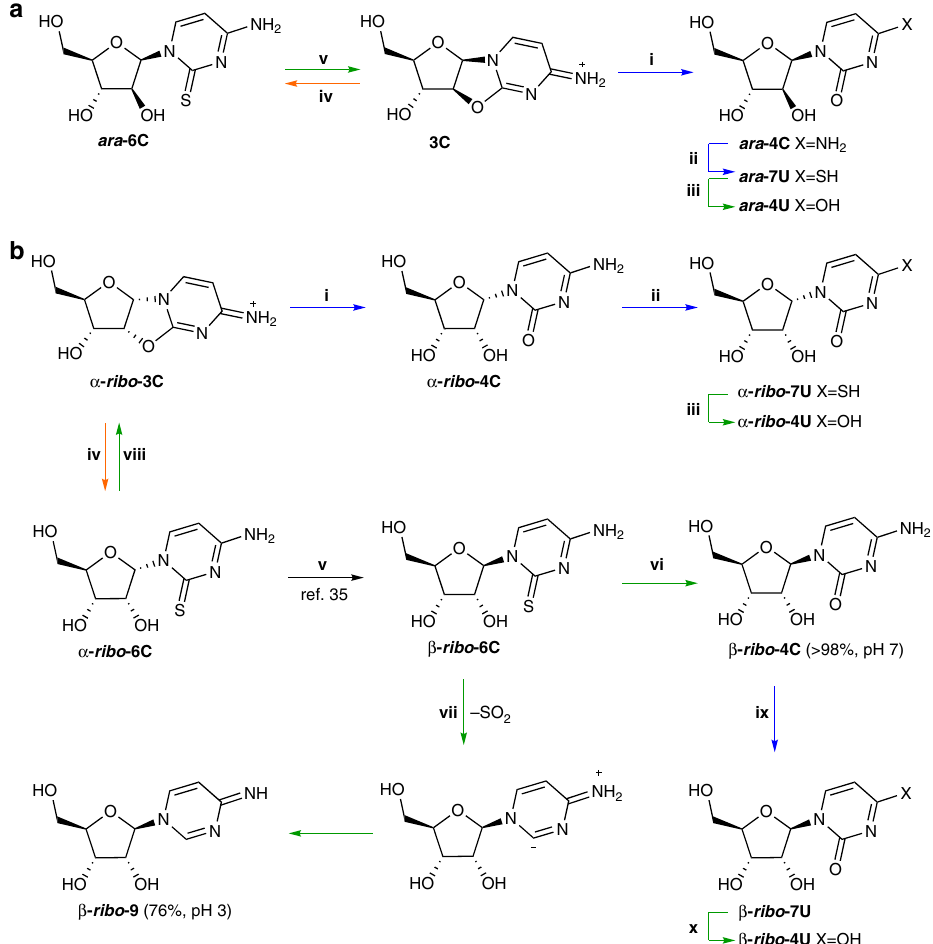
Fig. 4 Thiolysis and oxidation of pyrimidine nucleosides. a i. H 2 S thiolysis of arabino -anhydrocytidine ( 3C ) in water (pH 7) furnished β - arabino -cytidine ( ara -4C ; quant.) rapidly; ii. ara -4C then undergoes slow addition of H 2 S to afford 4-thio- β - arabino -uridine ( ara -7U ). iii. H 2 O 2 oxidation of ara -7U in